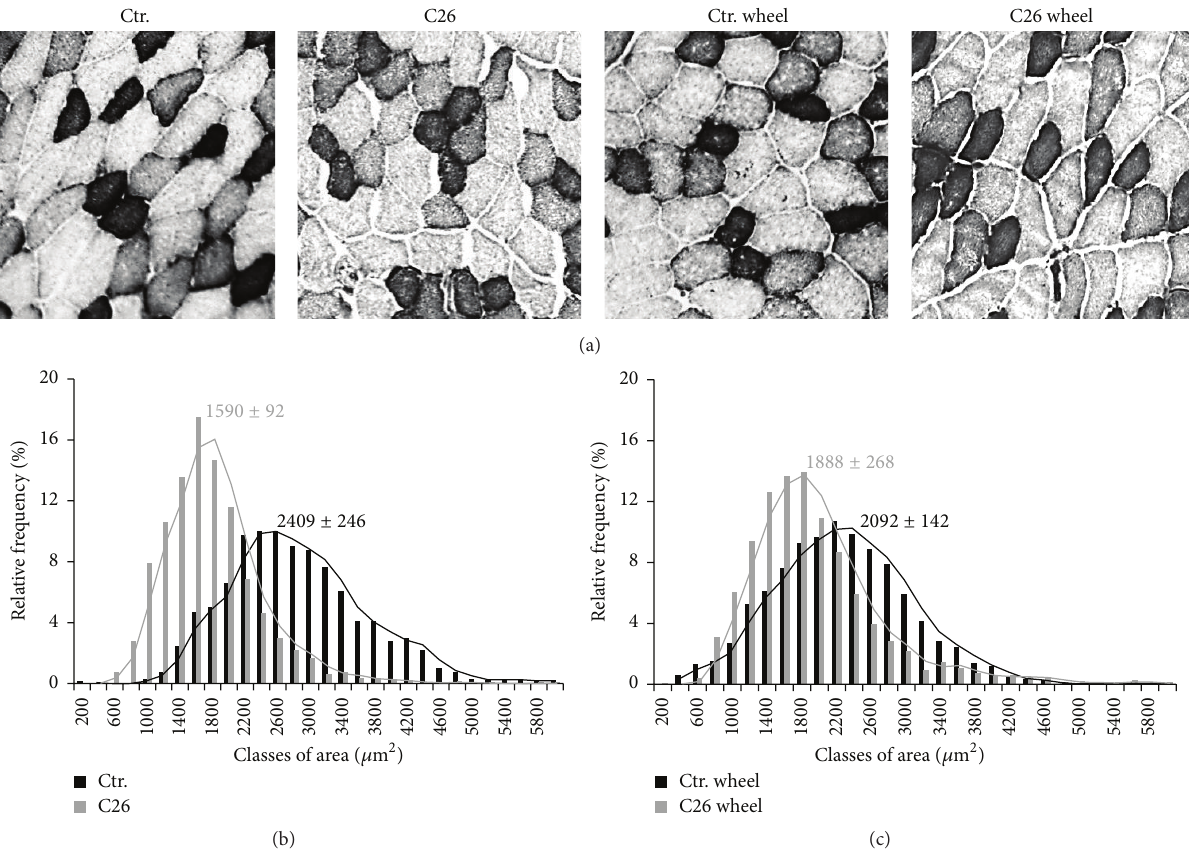
Figure 6: Voluntary wheel running rescues skeletal muscle atrophy in C26-bearing mice. (a) NADH staining in TA muscles. Glycolytic fibers are shown as pale colored while oxidative fibers stain as dark. Bar = 100 𝜇 m. Morphometric analysis of glycolytic fibers among healthy controls (black bars) and C26-bearing mice (gray bars) at rest (b) and in the presence of voluntary wheel running (c). Numbers represent the median value ± SEM of three independent experiments (C26 versus C26 wheel: 𝐹 = 1126 ; 𝑝 = 0.0001